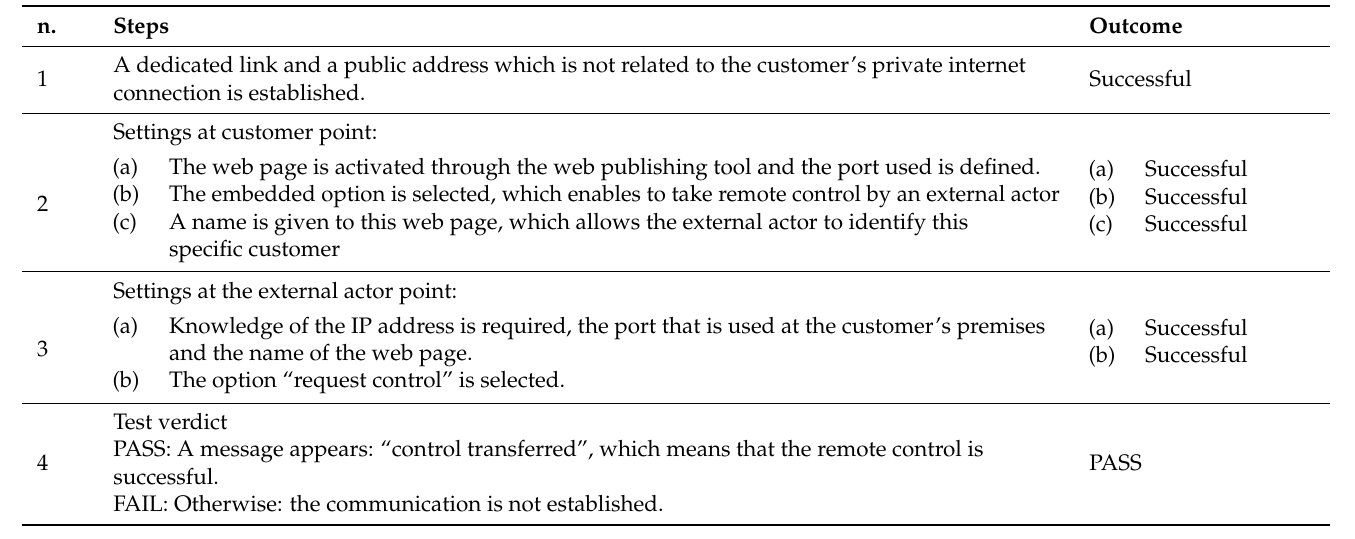
Table 6. Steps for communication layer interoperability and outcome of